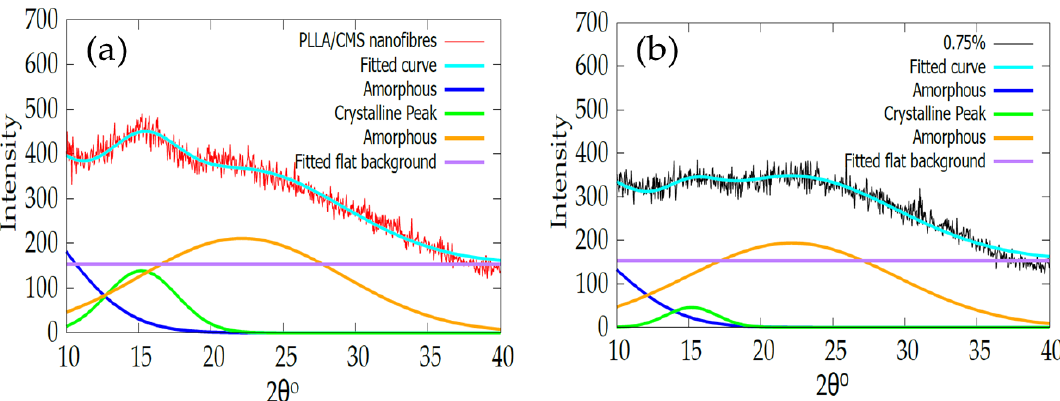
Figure 11. Indicates the changes in crystallinity peaks of 2 different compositions of ( a ) without β - TCP and ( b ) 0.75% β -TCP fitted with the Gaussian equation.